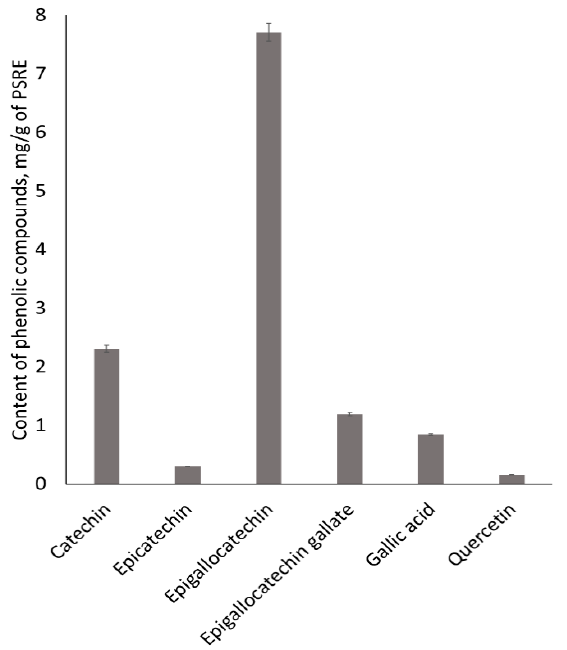
Figure 1. Content of phenolic compounds (mg/g) determined in Pelargonium sidoides root extract (PSRE).